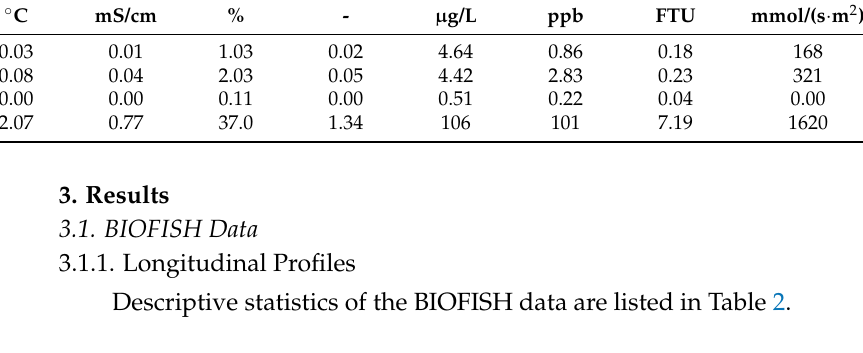
Table 2. Descriptive statistics of the BIOFISH data (n =